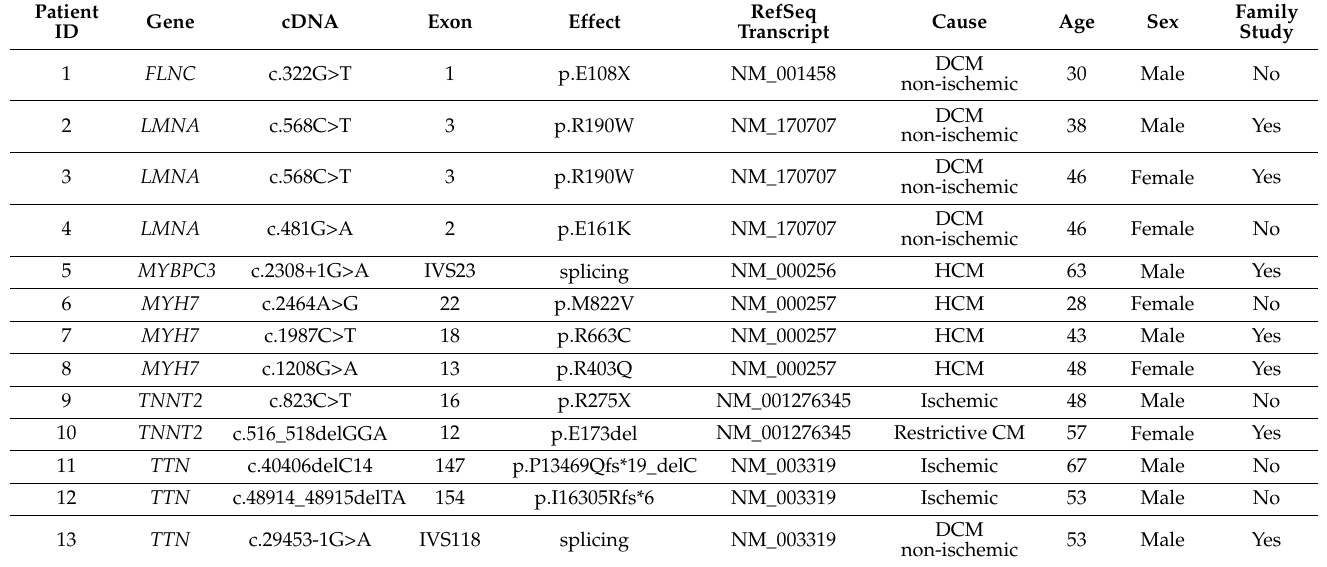
Table 2. Pathogenic/likely pathogenic variants and associated heart transplantation cause. Variants